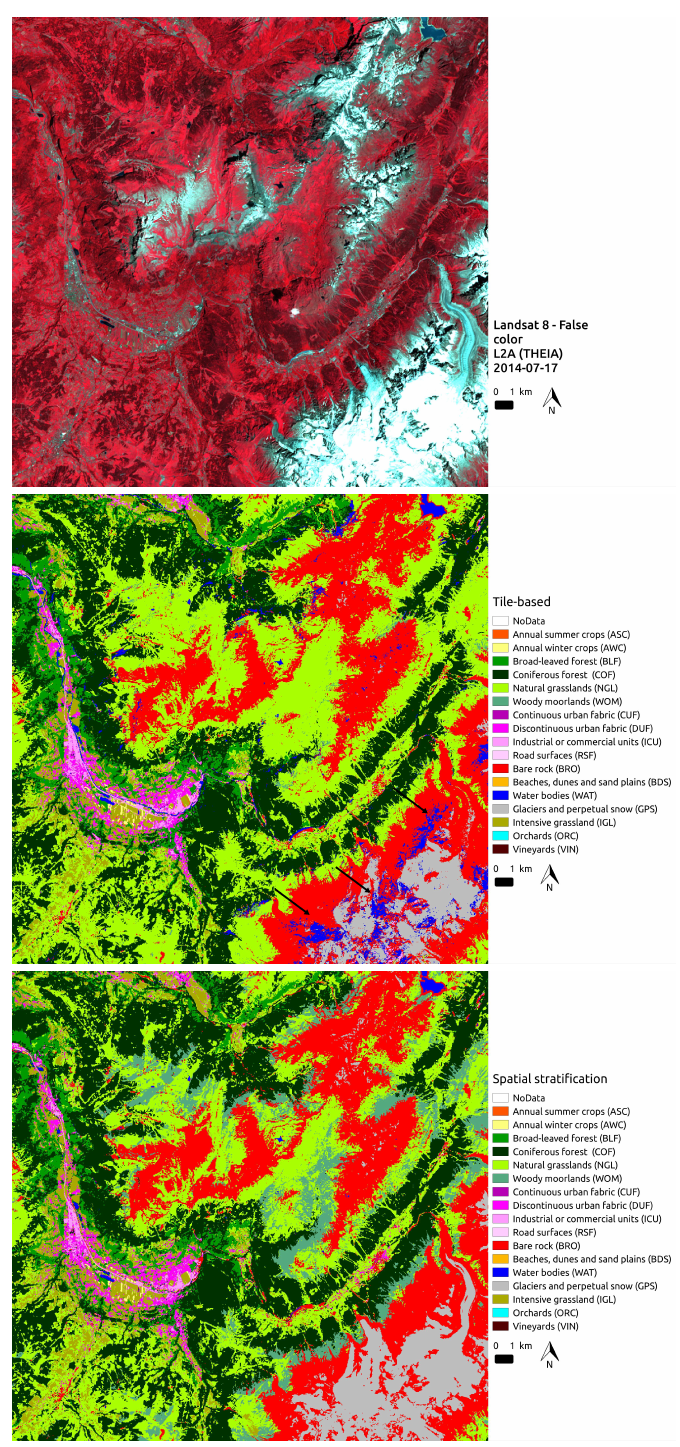
Figure 21. Analysis of errors over snow and ice. Examples of water over detection are indicated with black